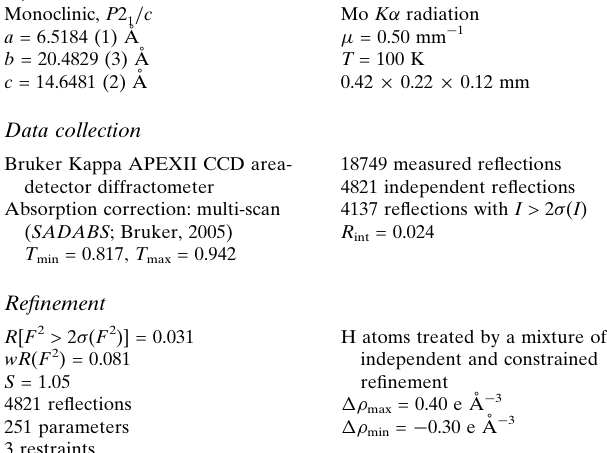
18749 measured reflections 4821 independent reflections 4137 reflections with I > 2 (cid:2) ( I ) R int = 0.024